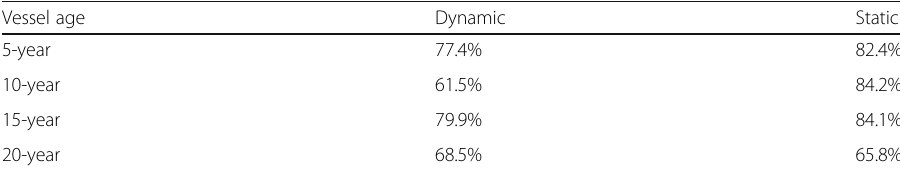
Table 6 Comparison of static and dynamic hedge efficiency Vessel